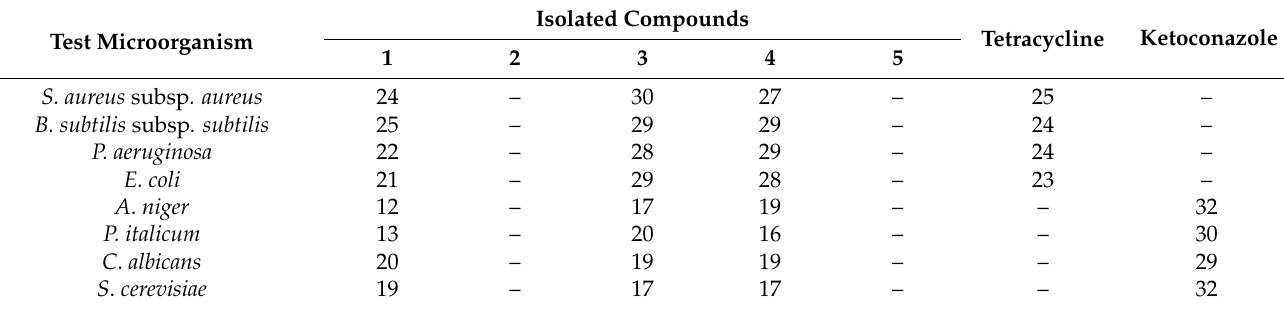
Table 3. Antimicrobial activities of five sufficient compounds isolated from the bark of C. obtusa var. formosana (diameter of the zone of growth inhibition, bactericidal or fungicidal zone in mm, including the diameter of the disc, 8